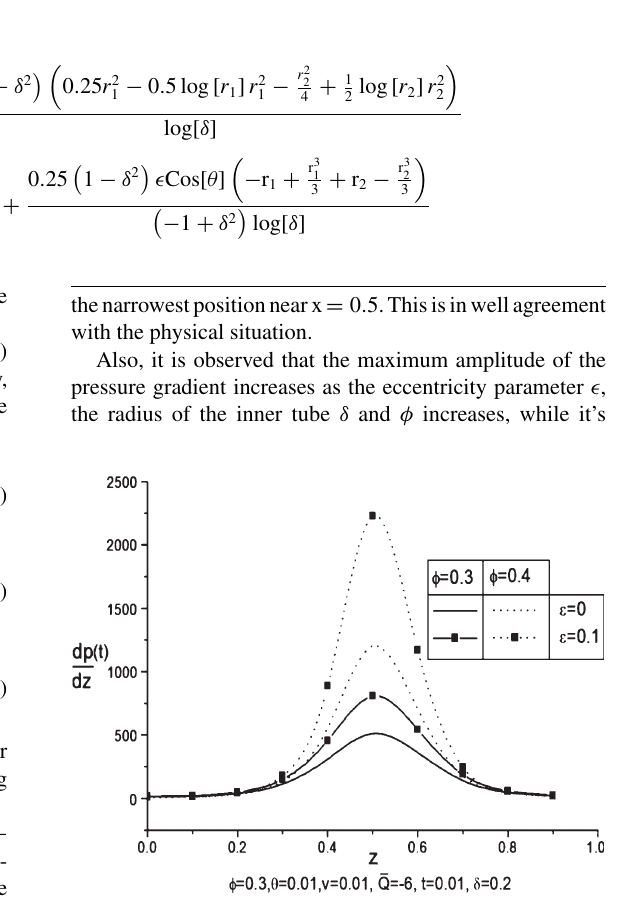
Fig. 2. Variation of pressure gradient over the length versus z with different values of amplitude ratio φ with different (cid:2) .